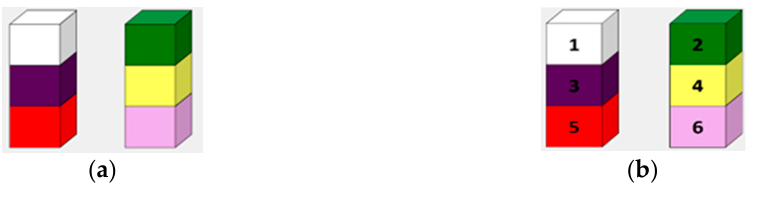
Figure 4. Sample of cubes configurations in ( a ) without complexity and ( b ) with complexity.